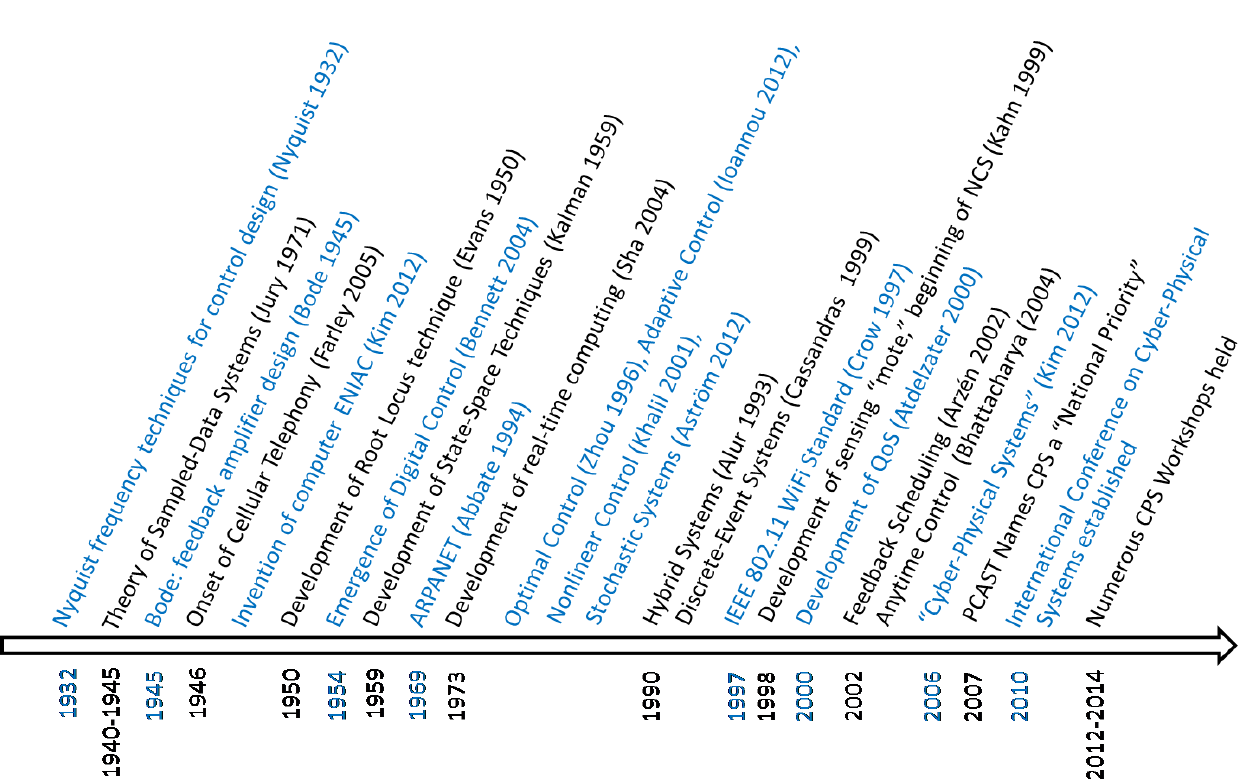
Figure 2. Cyber-physical system (CPS)